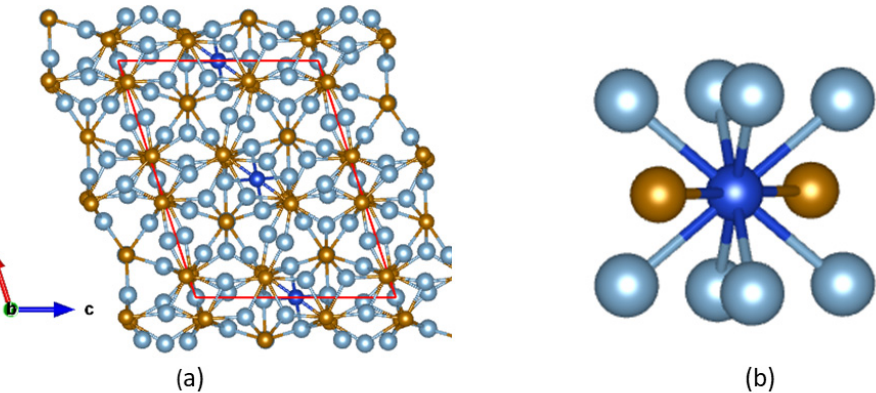
Figure 5. (Color on line) Schematic structure of the ternary θ -Al 76 Cu 2 Fe 24 phase projected along its [010] orientation and the related coordination of Cu by Fe and Al ( b ). The meaning of the spheres is the same as in Figure 2. The red lines in ( a ) represent the axis. The calculated lattice parameters, formation energy, and coordinates of atoms in θ -Al 76 Cu 2 Fe 24 . The related results for the parent 78 Fe 24 are included for sake of comparison. * The Al7 sites are occupied by